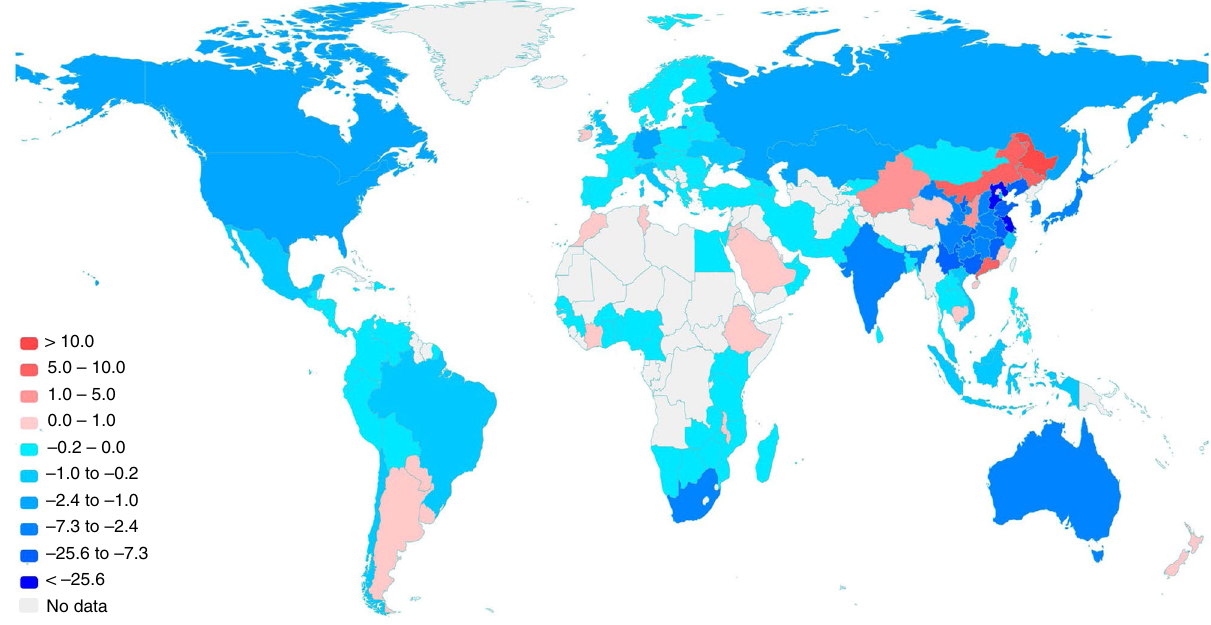
Fig. 3 Changes in CO 2 emission amounts of nations and Chinese regions (Mt), with conditions of saving rates of all Chinese regions decreasing by 15- percentage points simultaneously and emission intensity as of 2012 (Scenario 1). Saving rate decrease in China would reduce CO 2 emissions in regions of blue colour, while increase CO 2 emissions in regions of red colour. A darker colour indicates a larger CO 2 emission